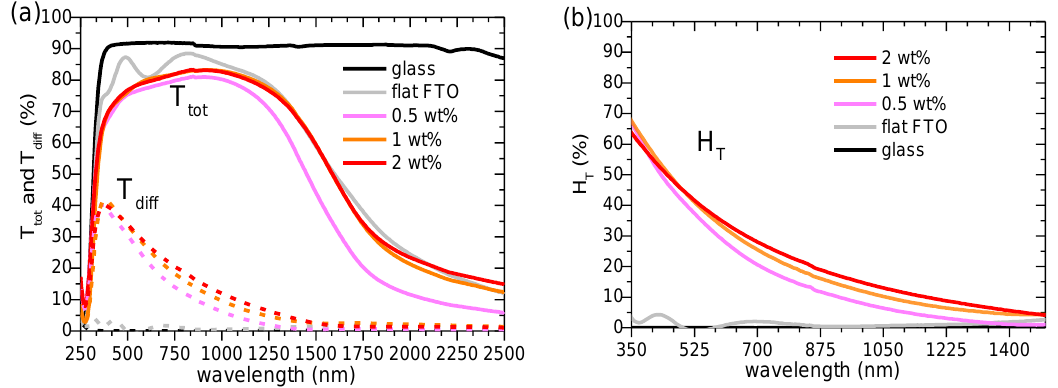
Figure 6. ( a ) Total transmittance (T tot ) and diffuse transmittance (T diff ) for Al 2 O 3 -FTO nanocomposites and respective reference flat FTO as well as the bare glass substrate; ( b ) Haze factor (H T ) for Al 2 O 3 -FTO nanocomposites and respective reference flat FTO as well as the bare glass substrate.